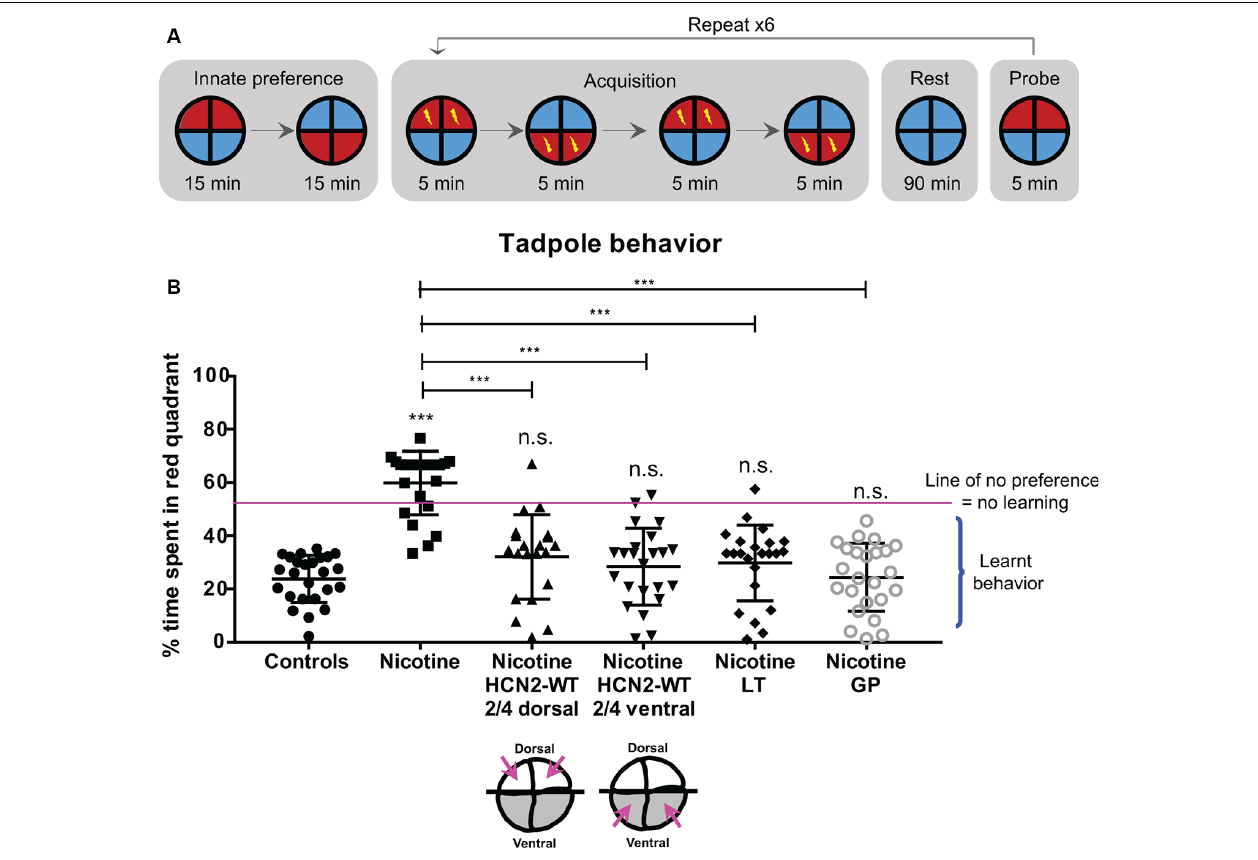
FIGURE 10 | HCN2 channels (local and distant) and HCN2 channel agonists restore associative learning capacity in nicotine-exposed embryos. Associative learning analysis for stage 45–50 tadpoles with indicated treatments. Lamotrigine (LT, stages 10–35) or gabapentin (GP, stages 10–35). (A) The training regime in the behavior analysis machine consisting of an innate preference test, a training phase (acquisition), a rest period, and a learning probe. Automated software executed a training cycle where animals received a shock when occupying the red half of the arena. Training, rest, and testing sessions were repeated a total of six times across the trial. (B) Quantification of time spent by each tadpole in the red-lit area during the final testing probe for each of the indicated treatments. Percentage of time spent by each tadpole in red light for each experimental group are Controls—24%, Nicotine—60%, Nicotine+HCN2-WT 2/4 dorsal—32%, Nicotine+HCN2-WT